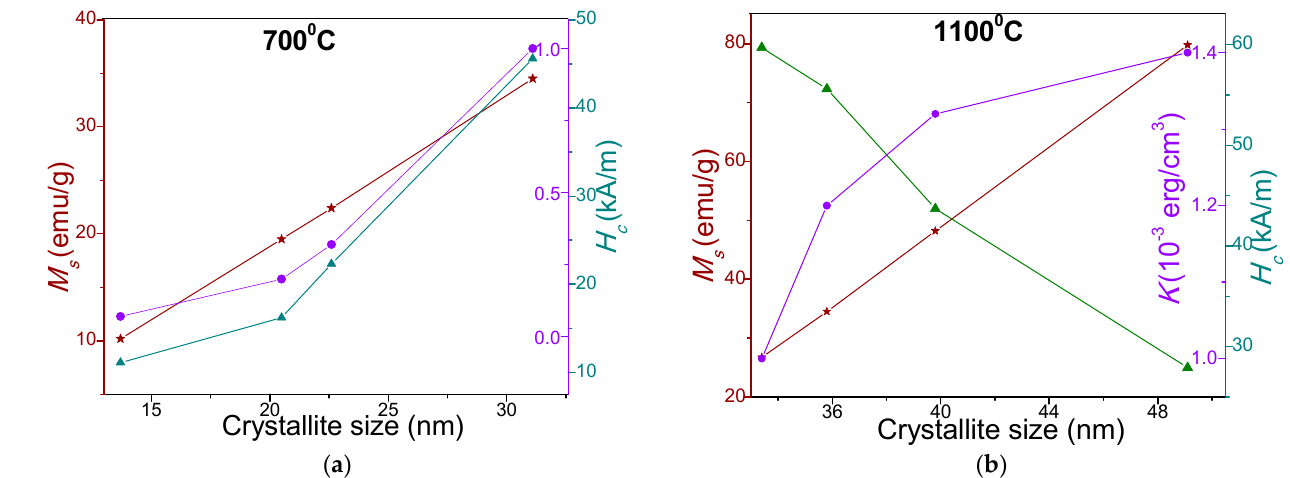
◦ C ( a ) and 1100 ◦ C ( b